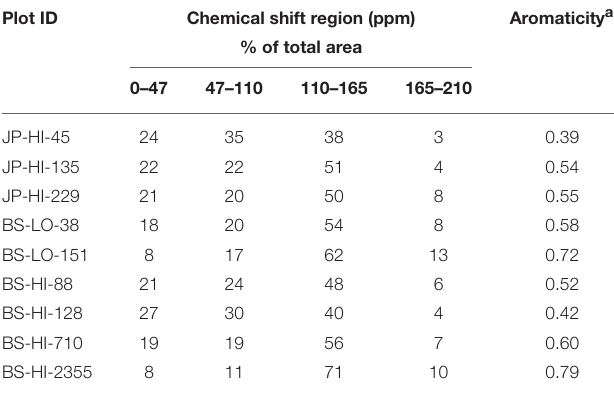
TABLE 4 | Relative intensity of chemical-shift regions of solid-state 13 C CPMAS NMR spectra of char samples. Plot ID